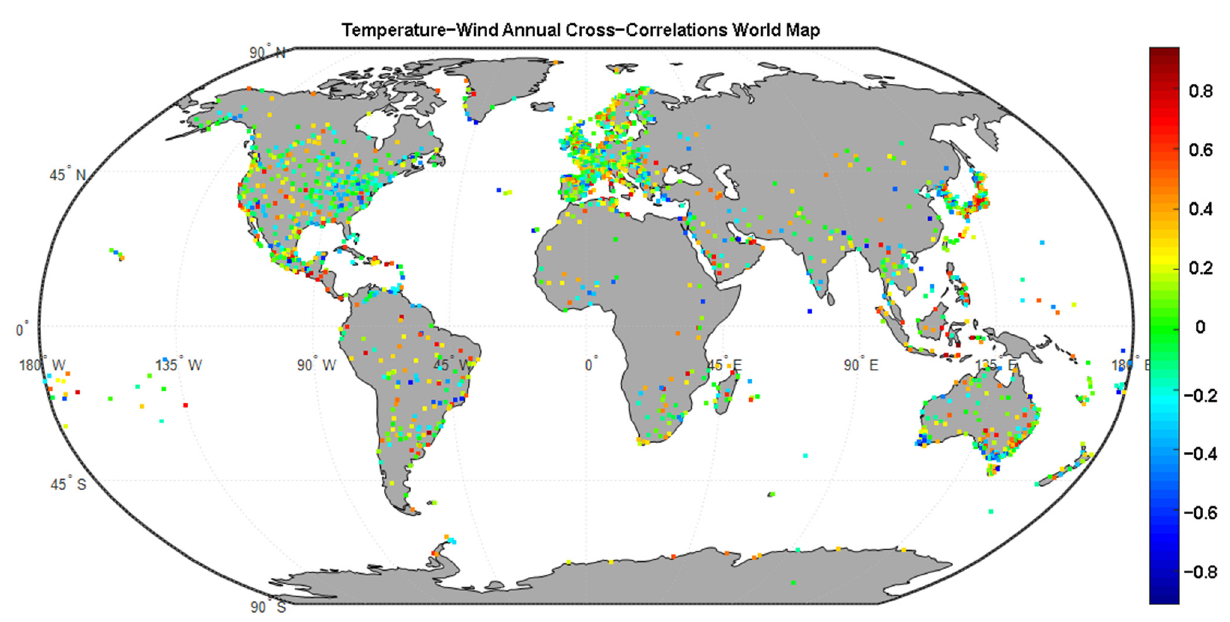
Figure 9. Cross–correlations between global ‐ scale temperature and wind ‐ speed records of annual resolution. Results are color coded from red (strong positive) to blue (strong negative) cross–correlations.